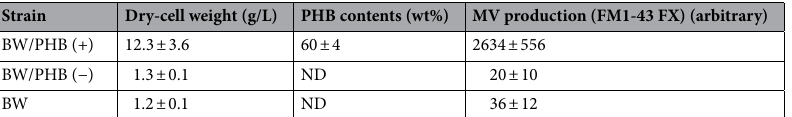
Table 1. Summary of dry-cell weight, PHB contents and MV production of each E. coli strain. Cells were cultivated in LB medium containing 2% (w/v) glucose at 30 °C for 48 h. The results are the averages ± standard deviations from three independent experiments.